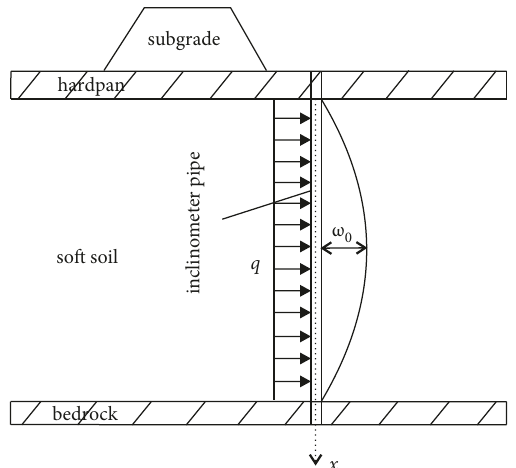
Figure 5: Stress analysis for the inclinometer when both ends are